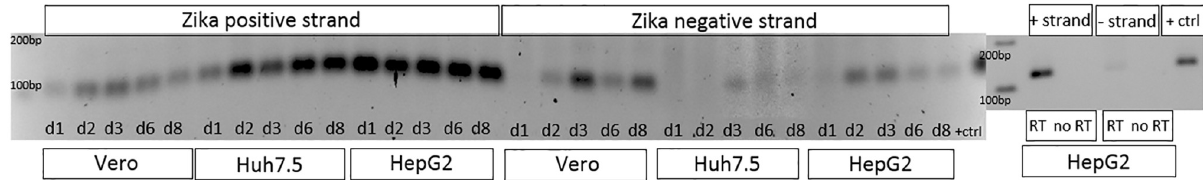
Fig 4. Agarose gel visualization of RT-PCR 113 bp products. Amplification of Zika RNA extracted from cell lysates from the target cell lines, at days 1,2,3,6, and 8 of infection. Positive strand products were amplified using the negative primer and negative strand products using the positive primer in the initial reverse transcription (RT) step. Product size is indicated by a 100 base pair ladder. To verify that no products were present without the initial RT step, representative HepG2 cell lysates were amplified with and without the reverse transcription enzyme. No bands appear in the lanes which had no RT enzyme. Positive strand virus with RT is more abundant than negative strand